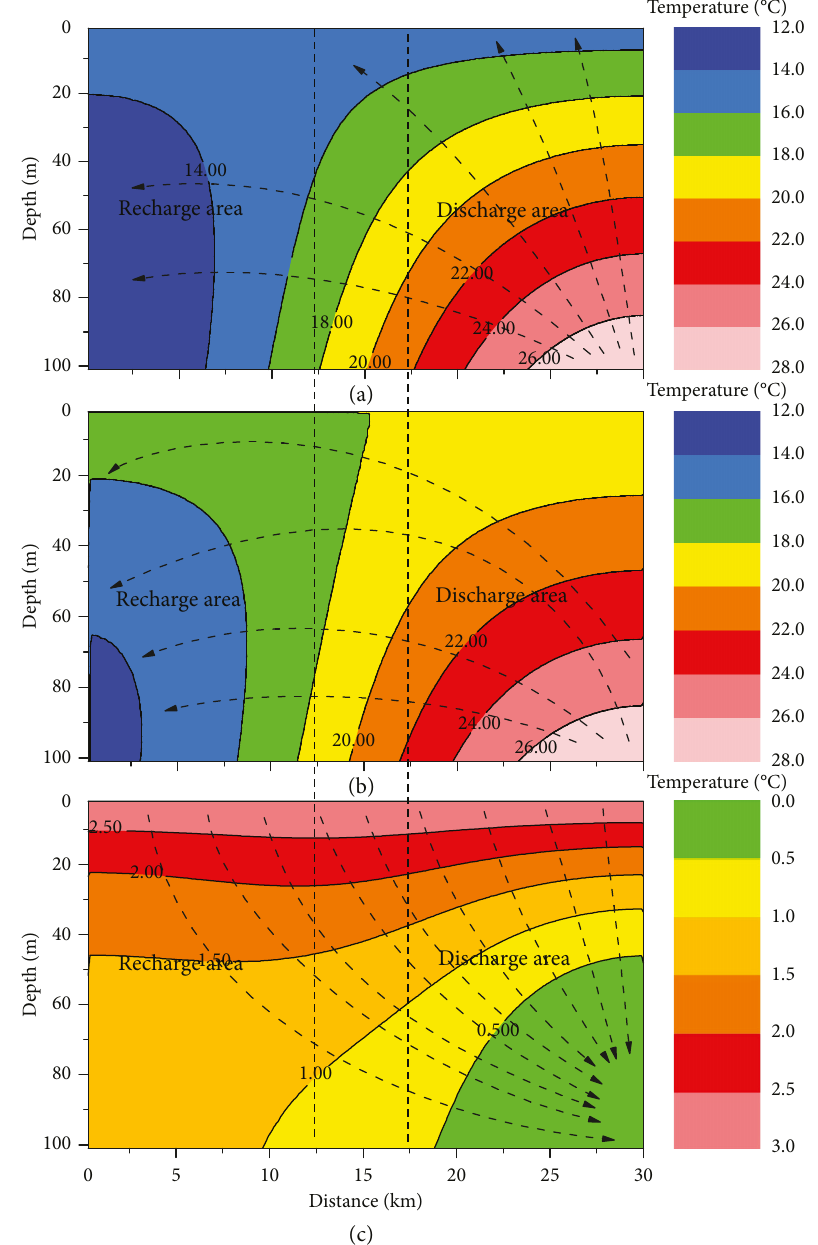
Figure 9: 2D diagrams showing (a) initial thermal distribution, (b) thermal distribution at t =100 years with linearly increasing surface temperature, and (c) di ff erences in thermal distributions between (b) and (a). The dashed lines with arrows represent the heat fl ow pro fi